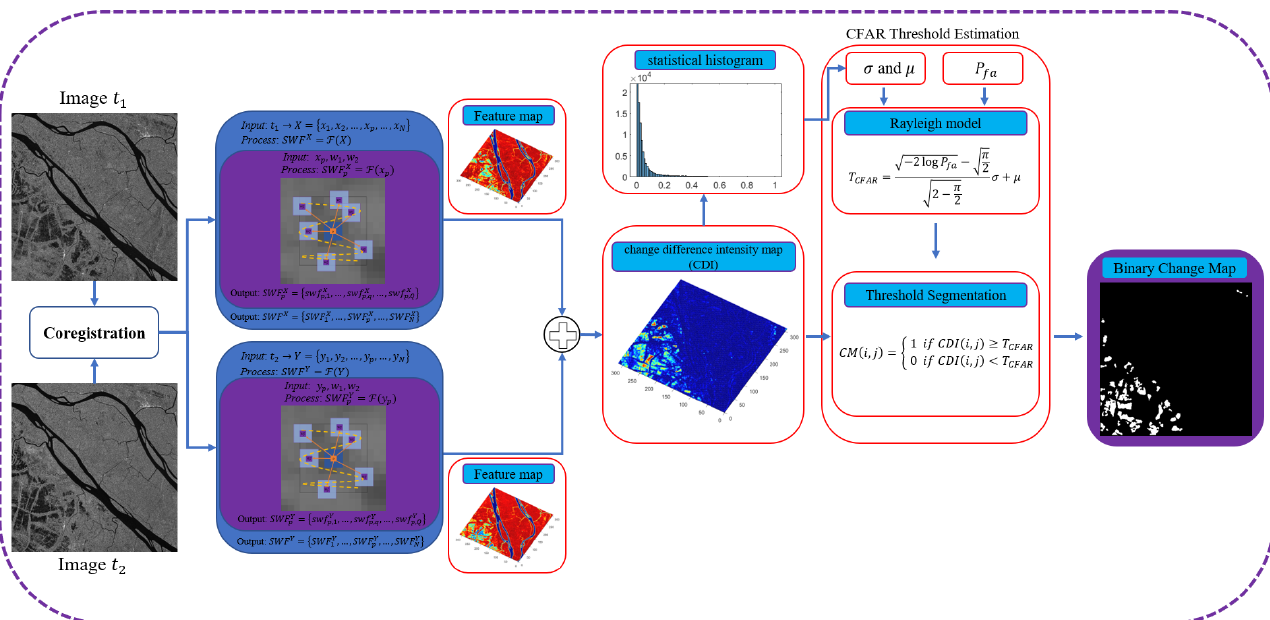
Figure 2. The framework of the proposed method. Note: the CFAR threshold segmentation method is employed in this diagram. In the experiments, the TAE, Otsu, and K&I threshold methods were also